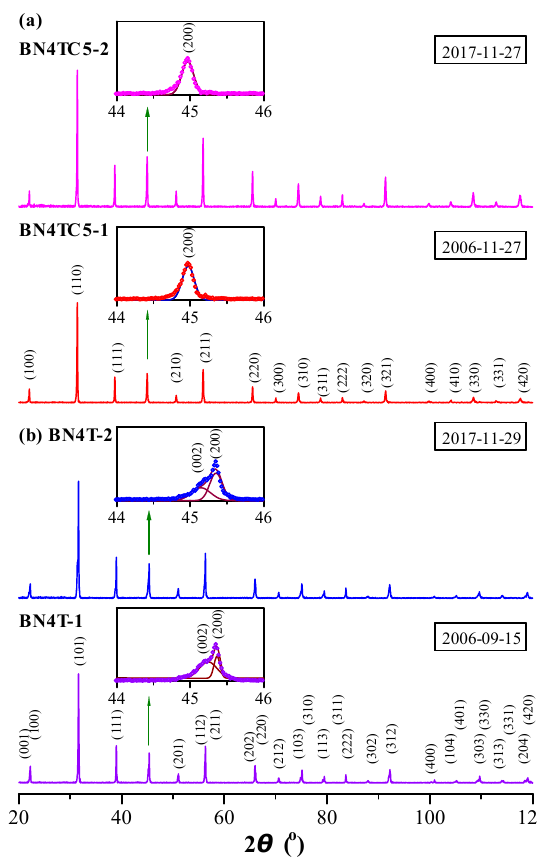
Figure 1. Powder XRD patterns of ( a ) BN4TC5 and ( b ) BN4T ceramics, measured in 2006 and again in 2017. The four insets on the left depict Gaussian fitting of the XRD peaks in the vicinity of 45°.